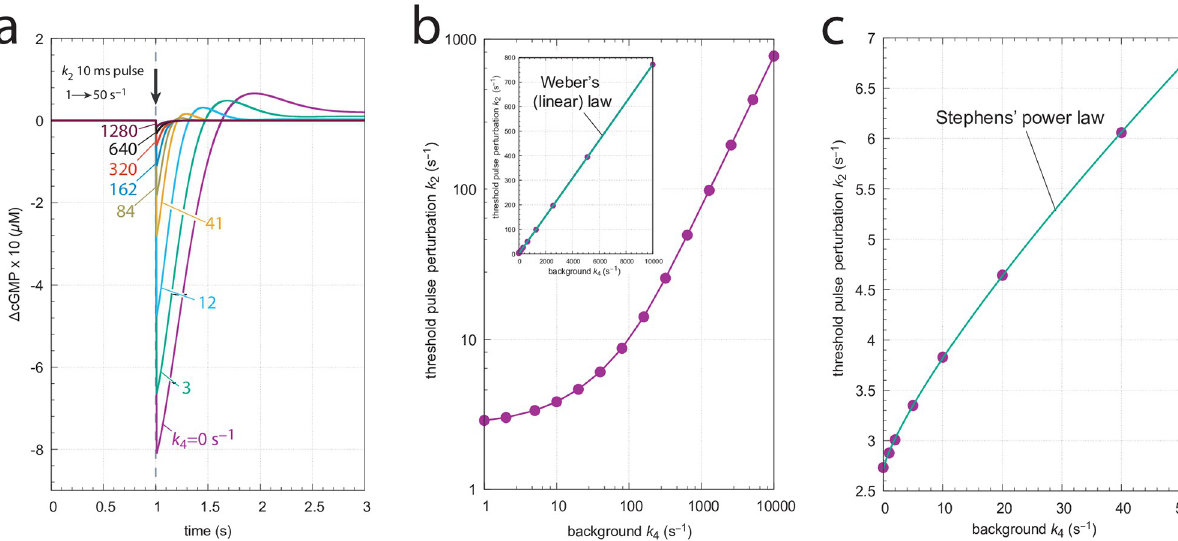
Fig 15. Application of 10 ms k 2 pulses (1 ! 50 s − 1 ) at different k 4 backgrounds. (a) the scaled Δ cGMP levels against time. Colored numbers indicate the different background levels in s − 1 . Initial concentrations (in μ M): cGMP 0 =9.04191, Ca 2 þ cGMP 0 =8.80039, Ca 2 þ ¼ 9 : 89550 � 10 (cid:0) 2 , K þ ¼ 2 : 52640 ( k 4 =3 s − 1 ); cGMP 0 =8.36375, Ca 2 þ 0 i ; 0 cGMP 0 =7.86039, Ca 2 þ ¼ 3 : 83237 � 10 (cid:0) 2 , K þ ¼ 6 : 52333 ( k 4 =41 s − 1 ); cGMP 0 =7.67946, Ca 2 þ 0 i ; 0